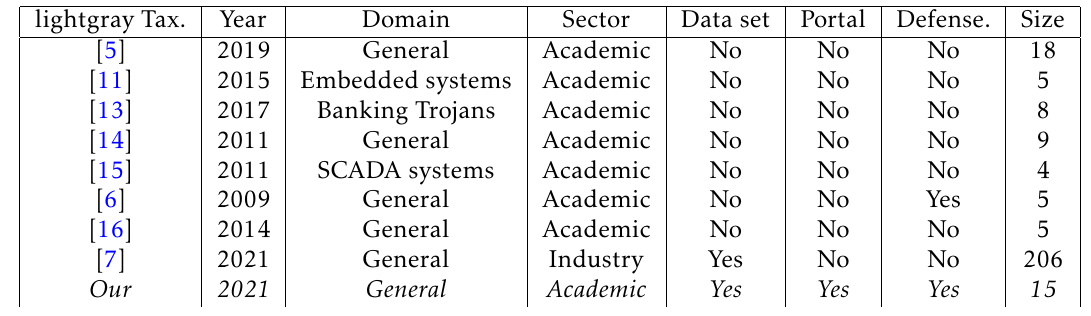
Table 1. Overview of existing taxonomies in comparison to our taxonomy.